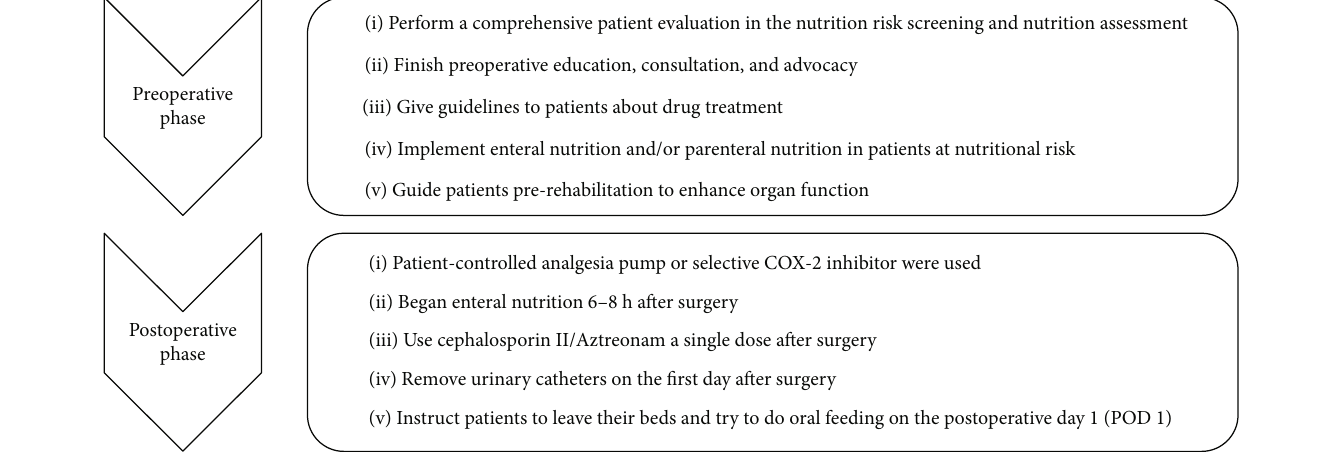
Figure 1: The key additional preoperative and postoperative elements of the Perioperative Surgical Home model at the Shanghai Ninth People ’ s